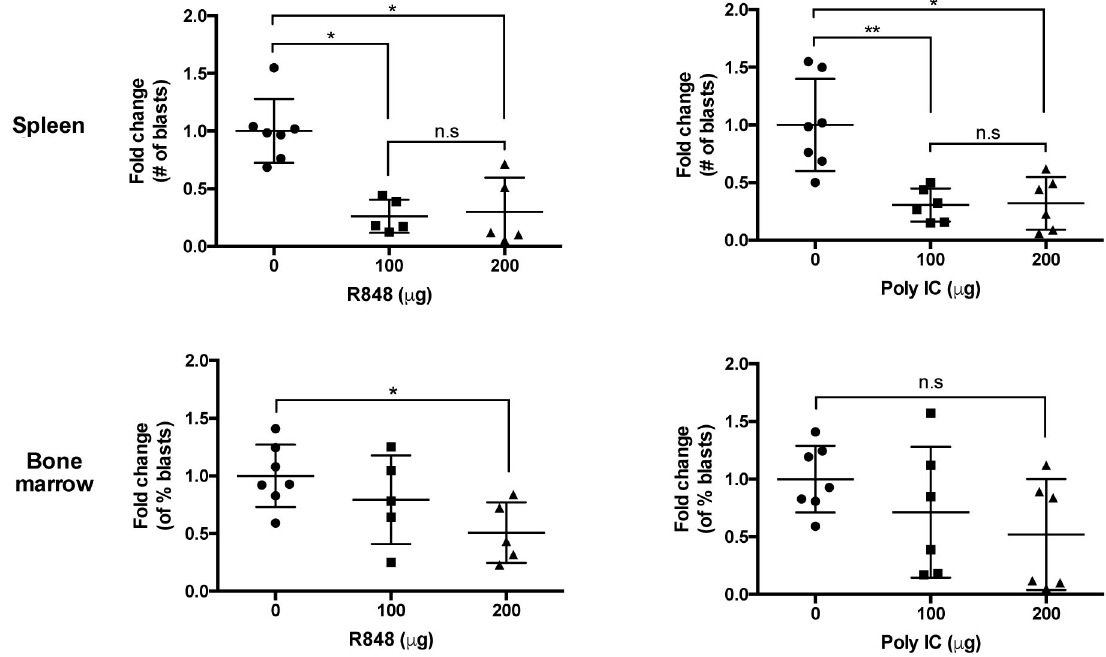
Figure A1. Comparison of dosage effects for TLR ligands. wt BALB/c mice bearing syngeneic primary B-ALL cells or 289 cell line received a single dose of indicated TLR agonists at 100 μ g or 200 μ g. Three days after the treatment, the disease burden in the spleen and bone marrow of polyI:C- and R848-treated mice were evaluated. Dunn’s multiple comparisons test, bars represent mean ± S.D. Results shown are pooled from two independent experiments; PBS-treated mice (n = 7); PolyI:C-treated mice (n = 6/dosage); R848-treated mice (n = 5/dosage) n.s = not significant.